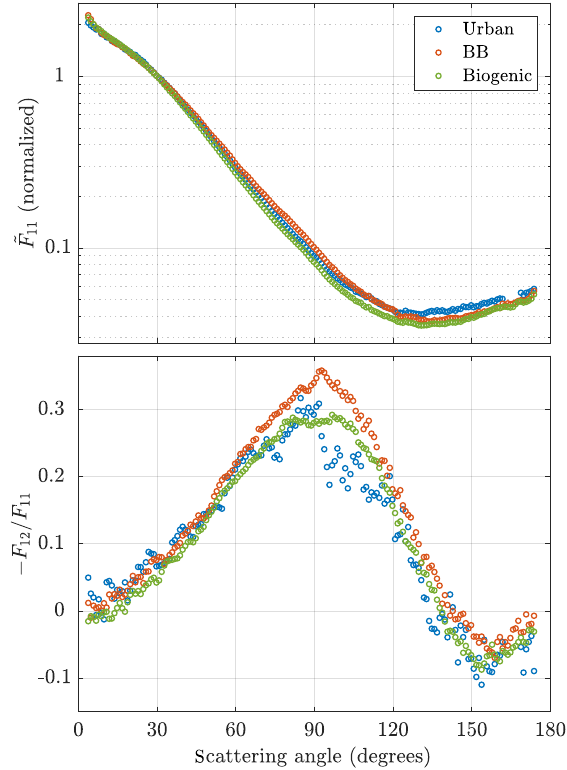
Figure 4. Average 532nm e F 11 and − F 12 /F 11 data for the three fine-mode-dominated aerosol classifications in SEAC 4 RS. Small gaps in the data (e.g., urban points ∼ 165 ◦ ) were removed due to strong biases from stray